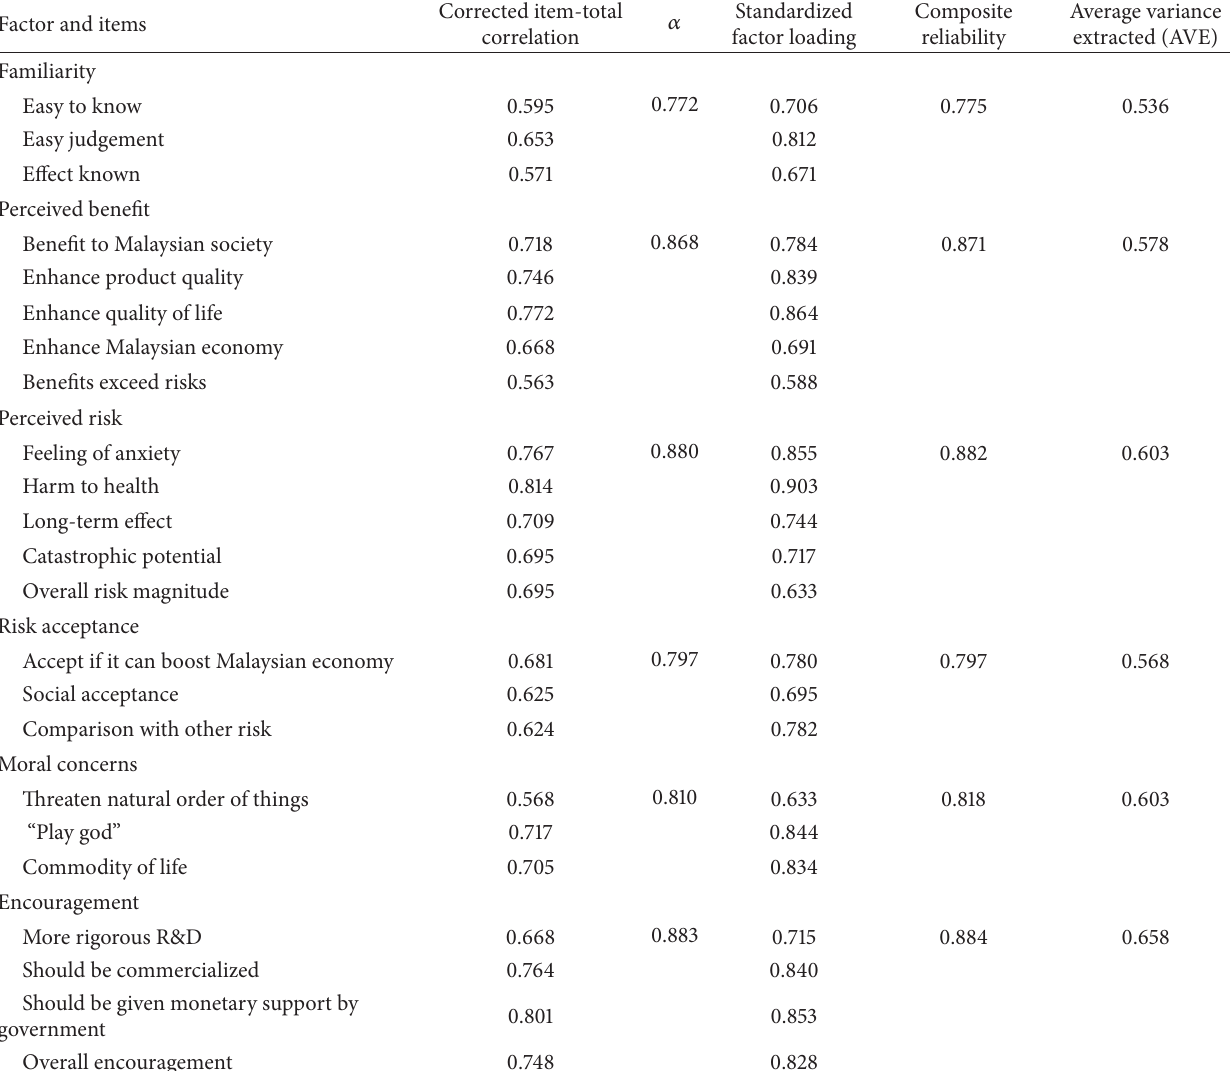
Table 2: Measurement scales, reliability, and